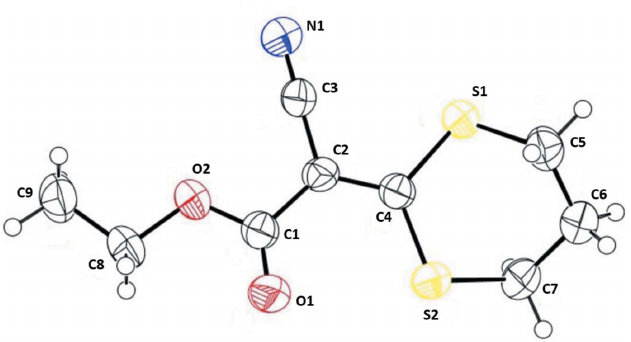
Figure 1 The molecular structure of the title compound (I), with the atom labelling. Displacement ellipsoids are drawn at the 50% probability